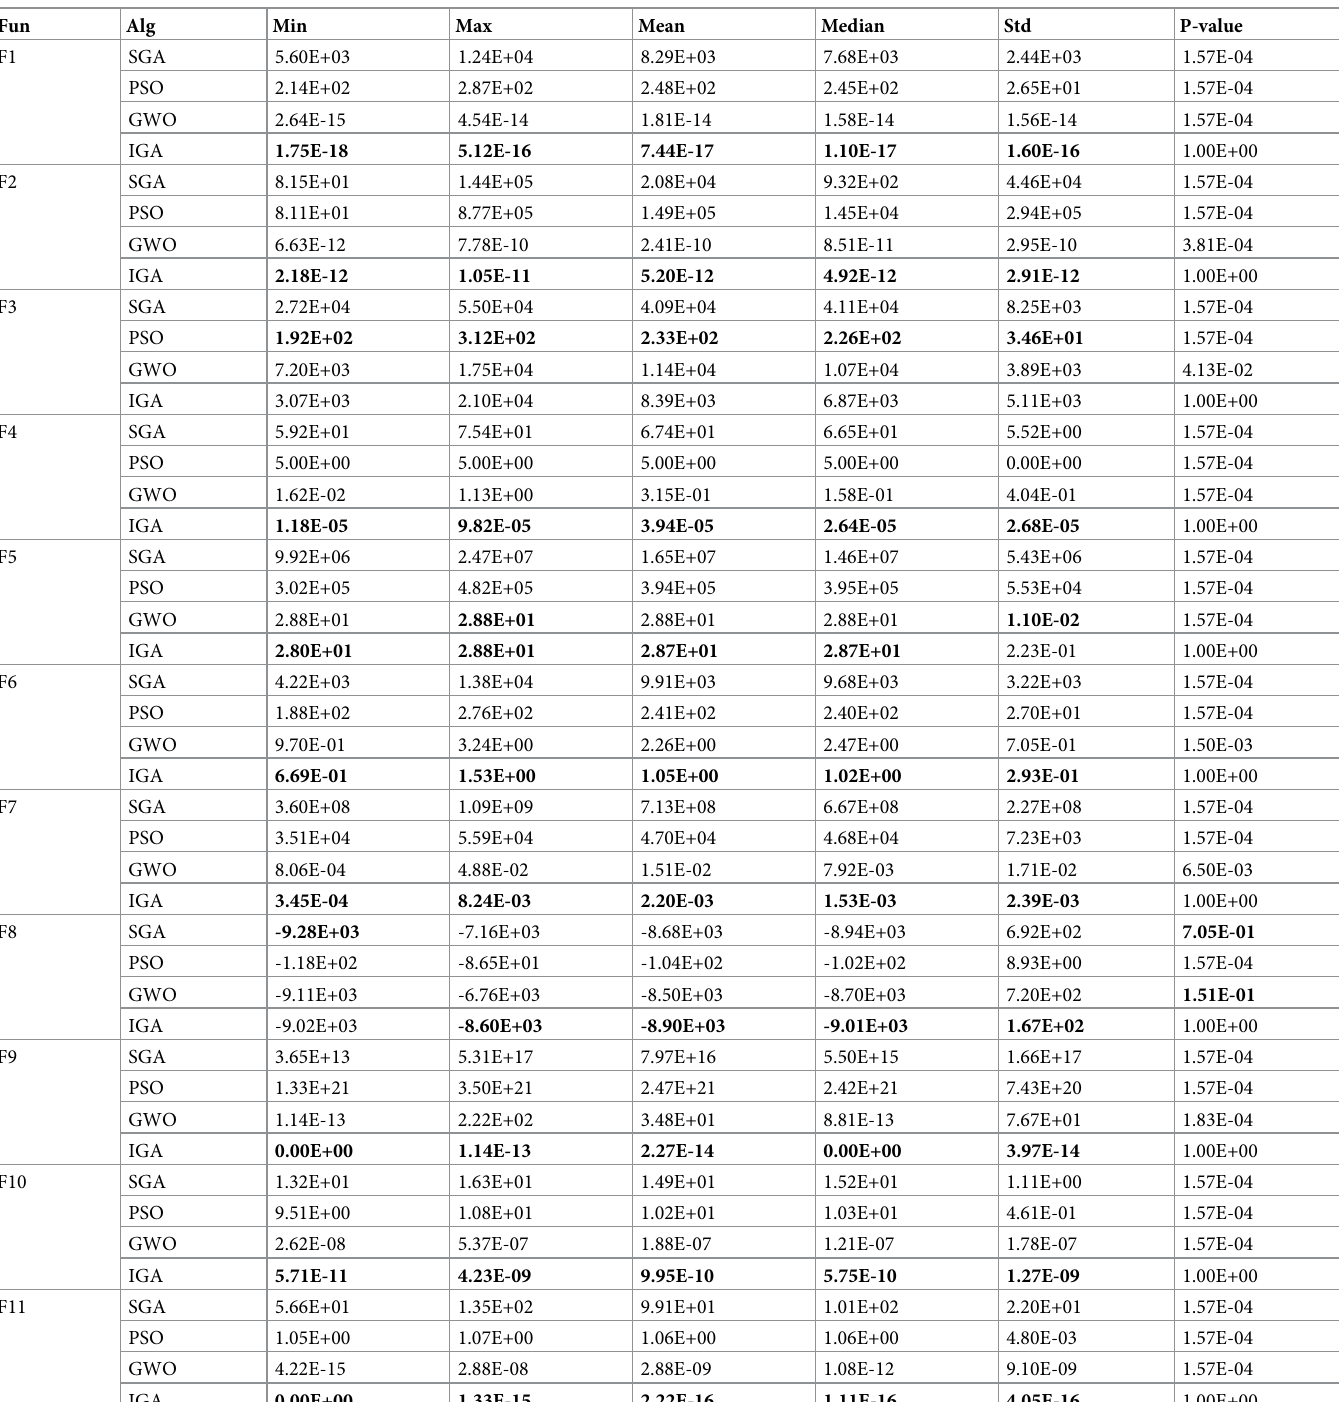
Table 5. Results of test functions (F1-F11) with 30